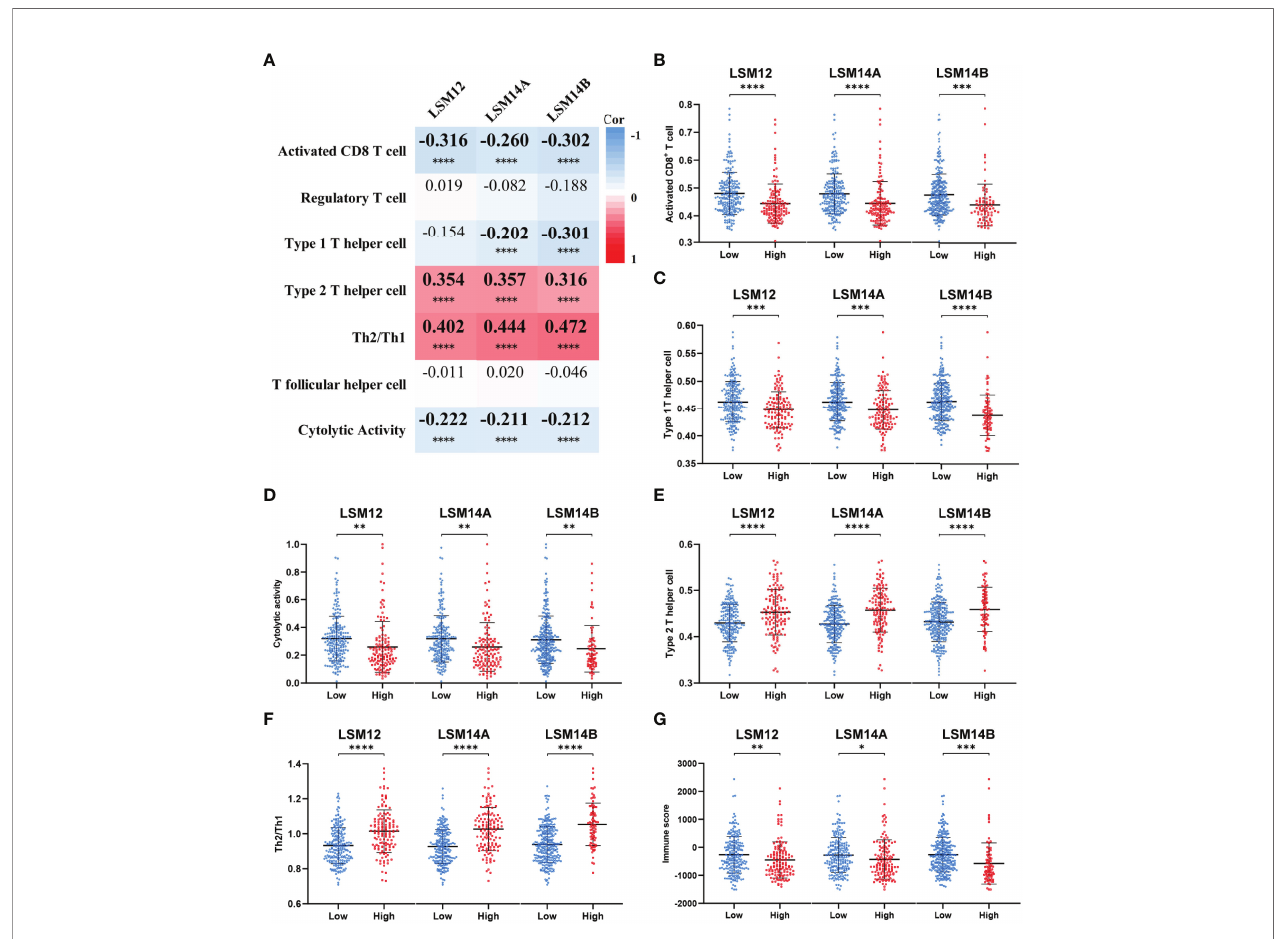
FIGURE 7 | Tumors with LSM12, LSM14A, and LSM14B overexpression were associated with an immunosuppressive phenotype. (A) Heat map to show the association between LSM12, LSM14A, and LSM14B expression and T-cell-related terms. (B) Tumors with higher LSM12, LSM14A, and LSM14B expression exhibited decreased activated CD8 + T-cell in fi ltration compared with those with lower LSM12, LSM14A, and LSM14B expression. (C) Tumors with higher LSM12, LSM14A, and LSM14B expression exhibited decreased Th1 cell in fi ltration compared with those with lower LSM12, LSM14A, and LSM14B expression. (D) Tumors with higher LSM12, LSM14A, and LSM14B expression exhibited decreased cytolytic activity compared with those with lower LSM12, LSM14A, and LSM14B expression. (E) Tumors with higher LSM12, LSM14A, and LSM14B expression exhibited increased Th2 cell in fi ltration compared with those with lower LSM12, LSM14A, and LSM14B expression. (F) Tumors with higher LSM12, LSM14A, and LSM14B expression exhibited increased Th2/Th1 compared with those with lower LSM12, LSM14A, and LSM14B expression. (G) Tumors with higher LSM12, LSM14A, and LSM14B expression exhibited decreased immune score compared with those with lower LSM12, LSM14A, and LSM14B expression. Th1, type 1 T helper cell; Th2 cell, type 2 T helper cell. *P-value <0.05; **P-value <0.01; ***P-value <0.001; ****P-value